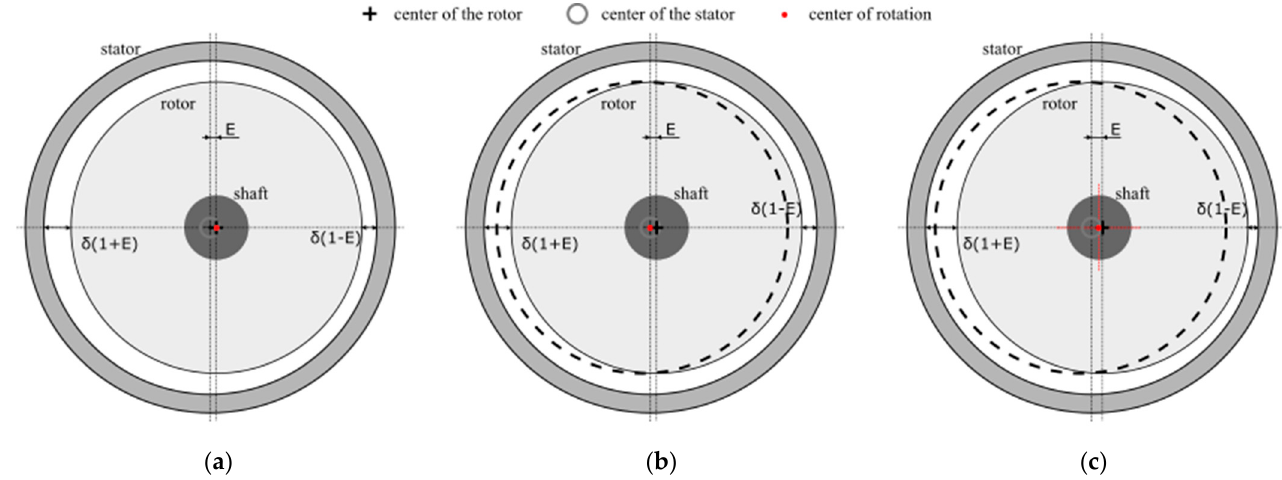
Figure 1. Eccentricity type description, ( a ) static, ( b ) dynamic, and ( c ) mixed. The most common signal for eccentricity diagnosis is the phase current, in which